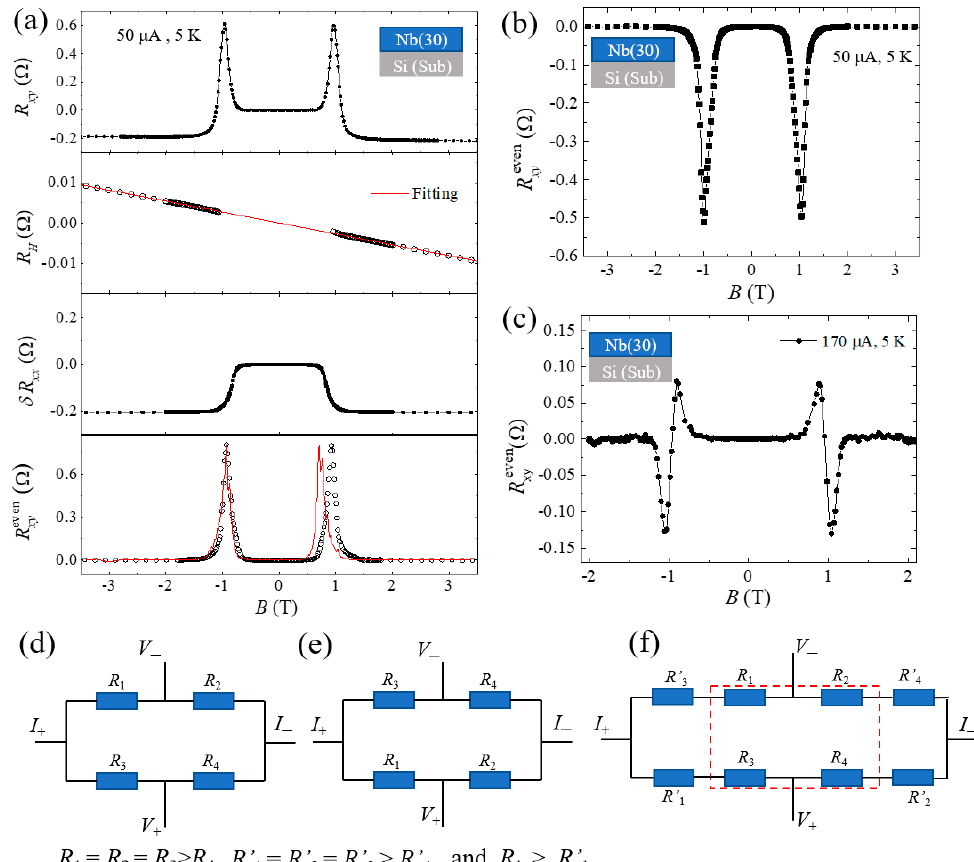
Figure 2. ( a ) The R xy , δ R H , R xx and R even xy changing with B from the top-to-bottom panel; the red line of the bottom panel is calculated by the four-resistance method. ( b , c ) are R even xy - B curve with opposite polarities shapes of peaks and oscillating behavior in other devices, respectively. ( d – f ) are the schematic structure of the four-resistance